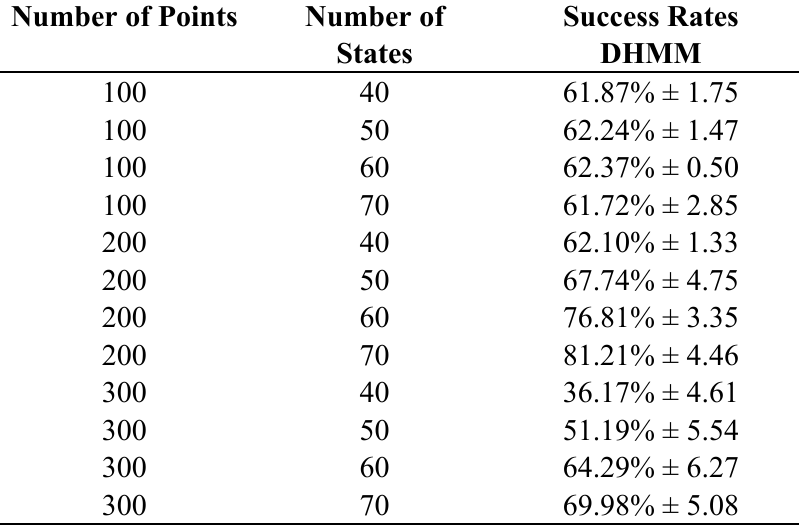
Table 4. Success rates for the DHMM with 144 users.